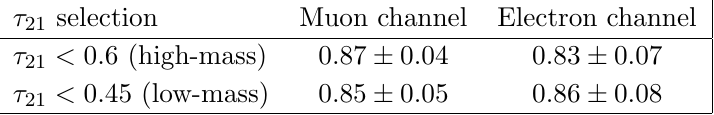
Table 5 . Data-to-simulation scale factors for tt and single top quark background processes, ex- tracted from the comparison between data and simulation in the top quark enriched control